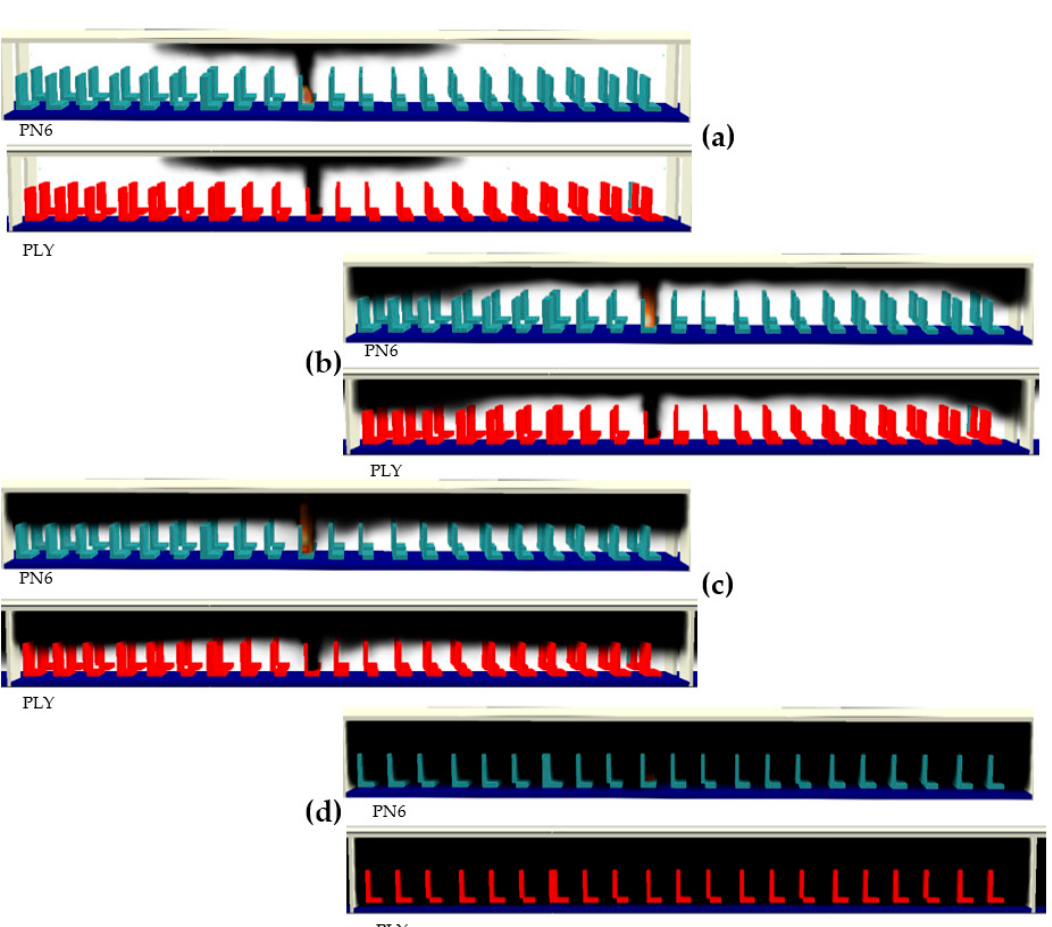
Figure 12. Smoke distribution for different seating materials after ( a ) 10 s, ( b ) 30 s, ( c ) 50 s, ( d ) 100 s.